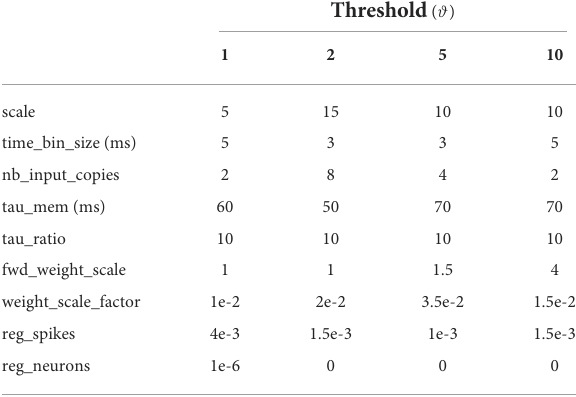
TABLE 3 Optimized values of the hyperparameters, for each encoding threshold, following grid